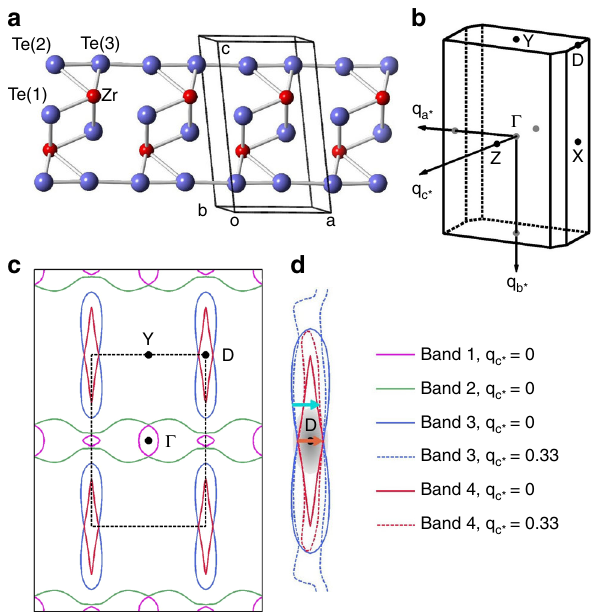
Fig. 1 Crystal structure and Fermi surface of ZrTe 3 . a The crystal structure. b The fi rst Brillouin zone. c Calculated Fermi surface (see ¼ 0. d Illustration of Fermi surface nesting properties. The Methods) at q c (cid:3) Fermi surfaces indicated in red and blue are relatively fl at sheets that run along the c (cid:3) direction perpendicular to the plane of display. Solid and ¼ 0 and q ¼ 0 : 33, dashed lines in d refer to the Fermi surfaces at q c (cid:3) c (cid:3) respectively, where the difference indicates Fermi surface warping along c (cid:3) . The electronic gap associated with the CDW order opens from the shaded region around the D-point. The orange and cyan arrows indicate slightly different nesting wave vectors along a (cid:3) (with fi xed 0.33 r.l.u. along c (cid:3) ) on different parts of the Fermi